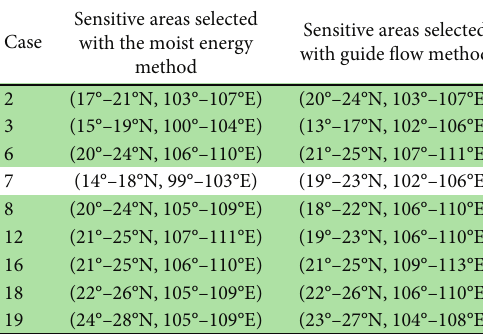
Table 6: Same as Table 5 but for verifying